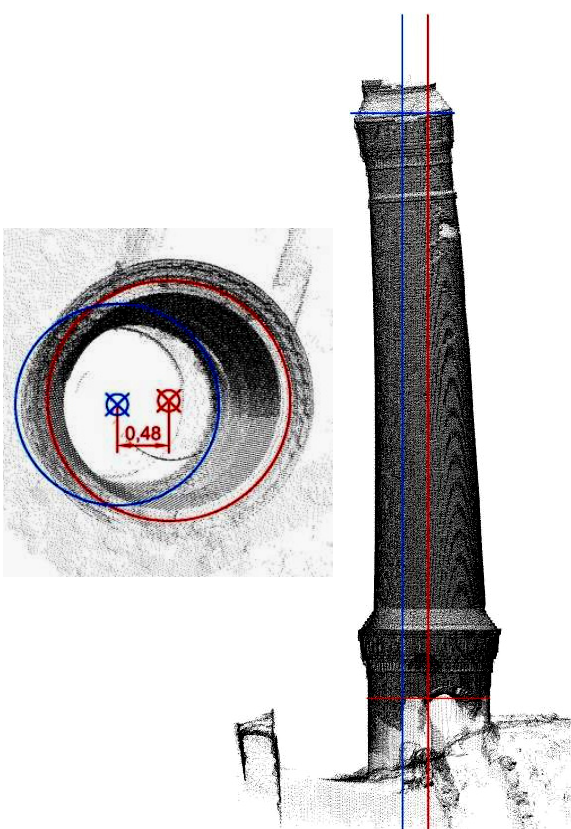
Figure 7: Ground plan and elevation, in which the displacement of the chimney can be noticed and measured (source: prepared by the authors)